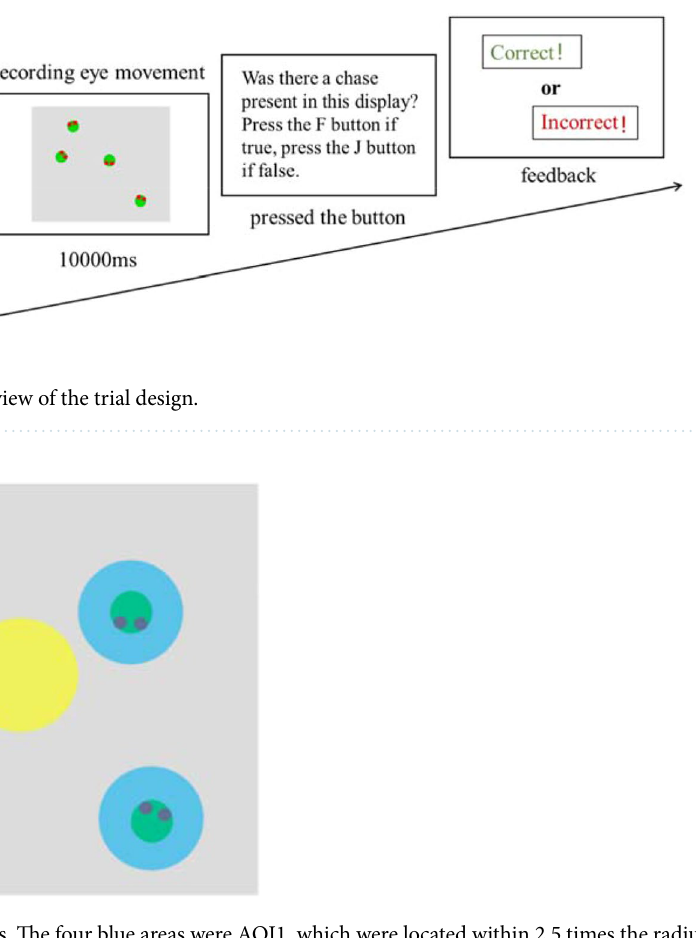
Figure 3. Samples of AOIs. The four blue areas were AOI1, which were located within 2.5 times the radius of every agent. The yellow area was AOI2, which was located within 2.5 times the radius of agent at the barycenter of 5